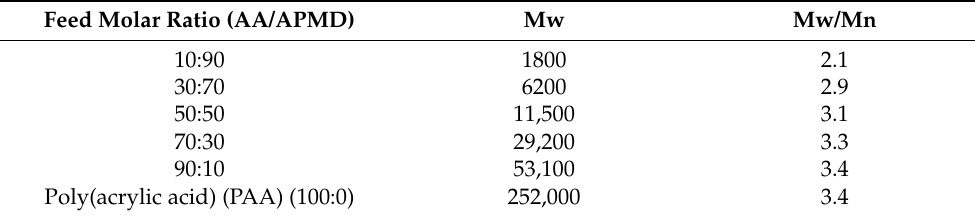
Table 1. Molecular weights of poly(AA– co –PMD) prepared from different feed compositions. Feed Molar Ratio